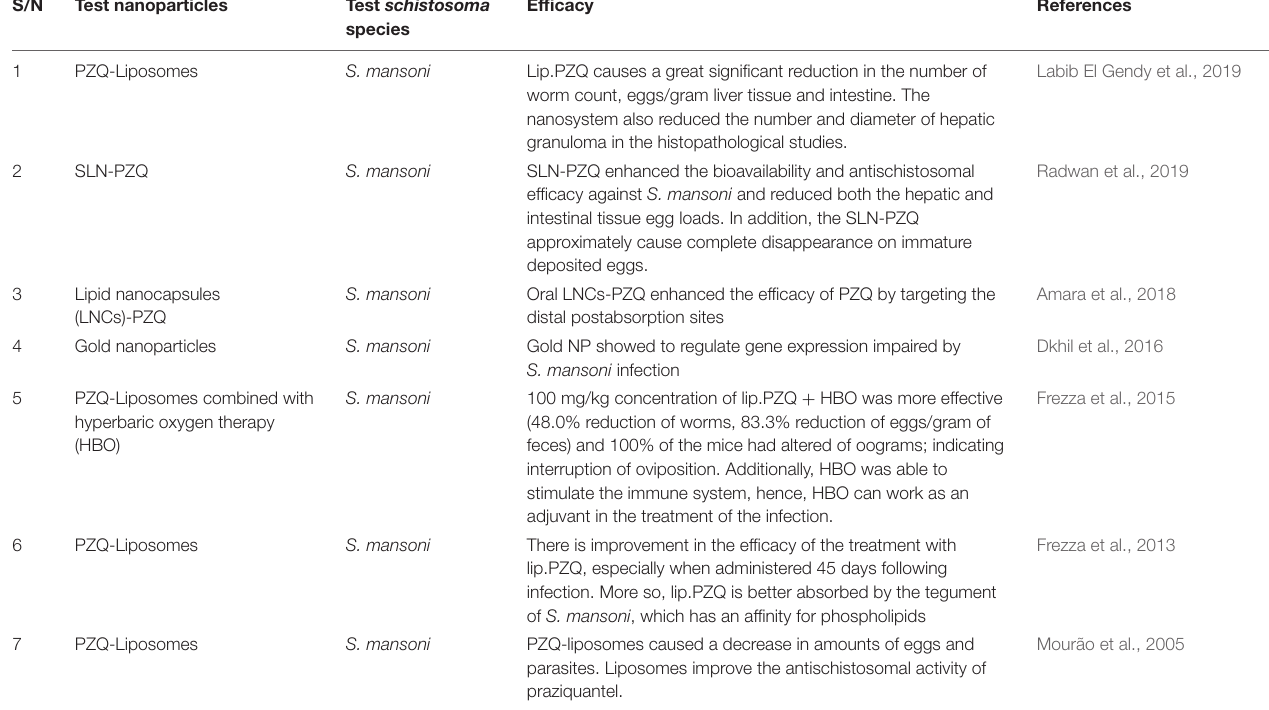
TABLE 3 | List of some nano-delivery systems which have been used in improving the therapeutic efficacy of PZQ in treating schistosoma